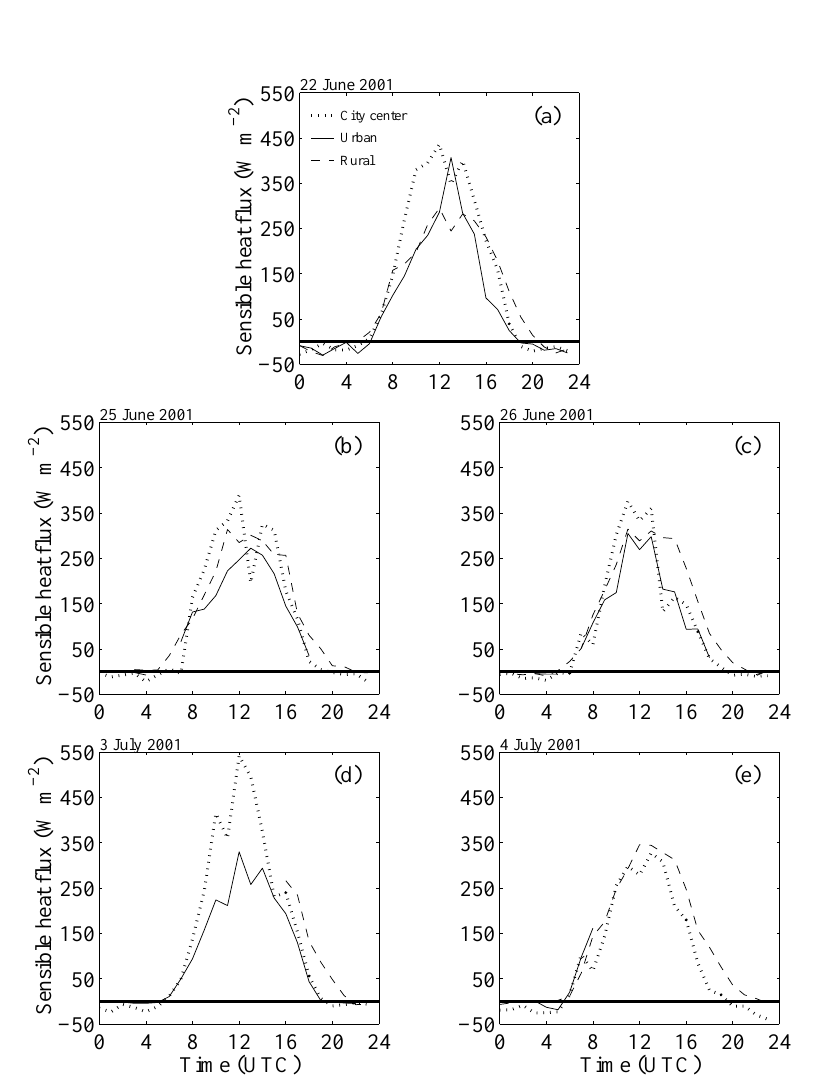
Fig. 9. Surface sensible heat flux measured in the Marseille city center (dotted line), in the less urbanized area of the city (solid line) and in the rural area (dashed line) on 22 June 2001 (a) , 25 June 2001 (b) , 26 June 2001 (c) , 3 July 2001 and 4 July 2001. The thick line corresponds to zero heat flux.